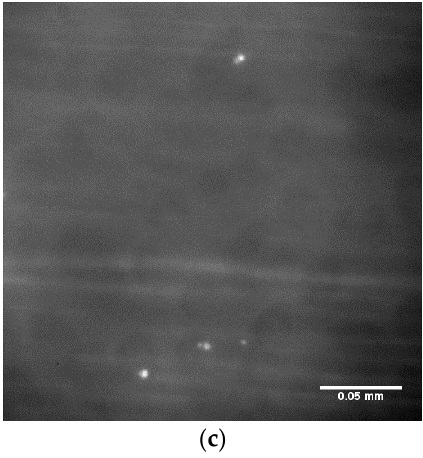
Figure 6. Fluoresence micrographs of 25PS/75PMMA demixed surface ( a ) with whole blood DIOC 6 labelled platelets adhered to the surface; ( b ) after addition of AK2 platelet antibody and ( c ) after inclusion of 5D2 vWF antibody. Scale bar 0.05 mm.